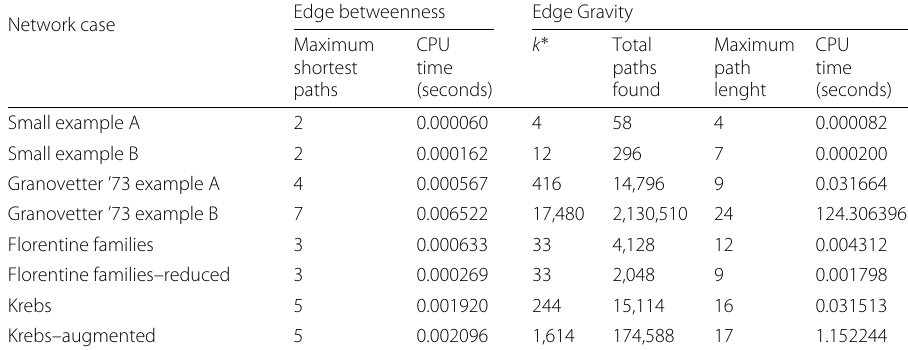
Table 3 Summary of computational results, executed on an Intel(R) Xeon(R) CPU E3-1270 v6